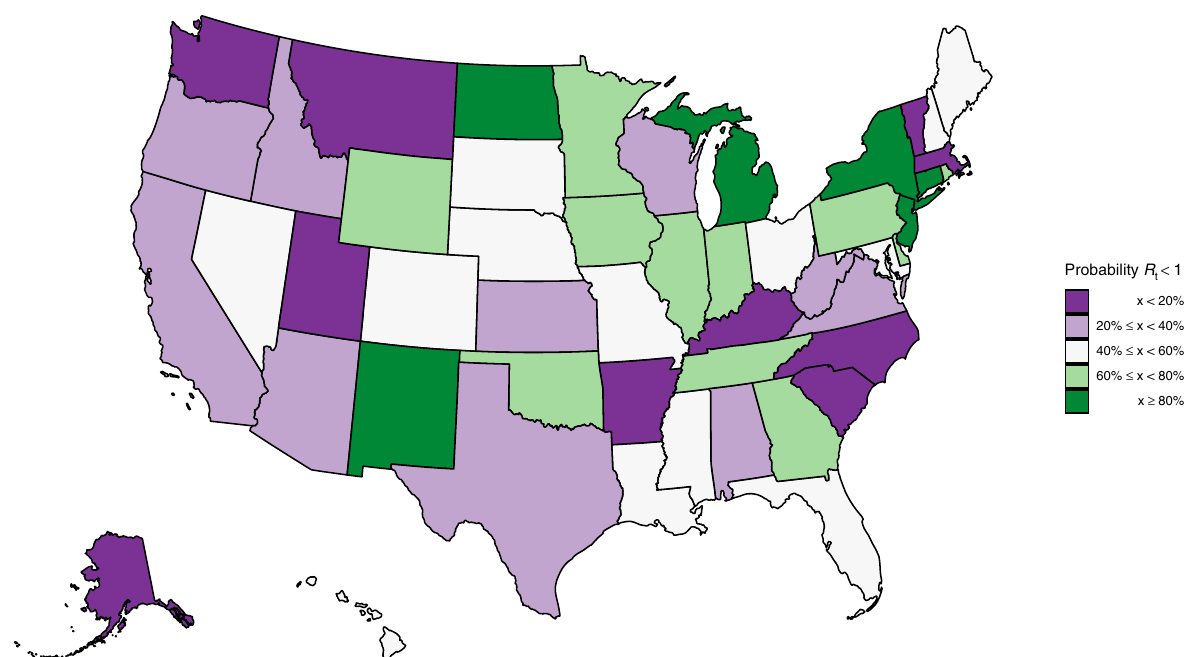
Fig. 2 Estimates of the probability that the time-varying reproduction number R t is less than one in each state. This plot shows the certainty that the rate of transmission is under control. These values are an average over the week ending 01 June 2020.